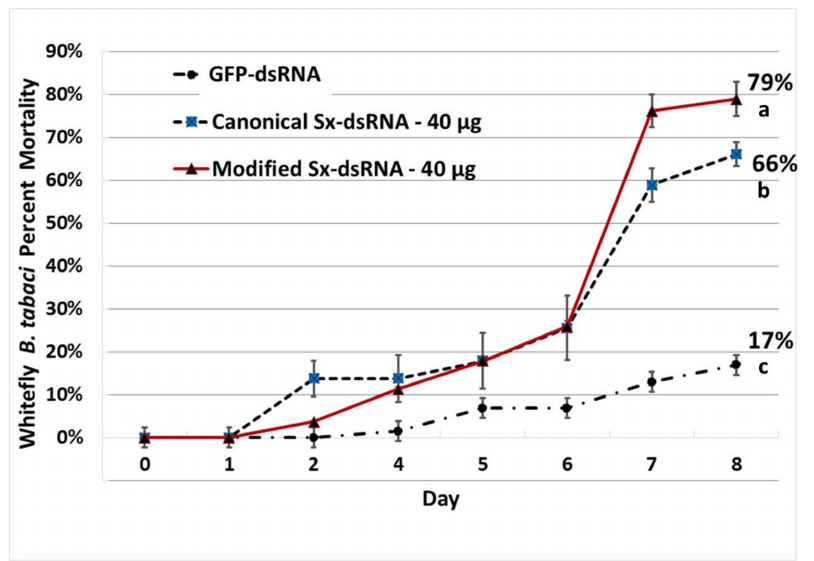
Figure 9. Average Percent Whitefly Mortality. Adult B. tabaci after an 8-d feeding access period on Syntaxin -dsRNA treated okra seedlings. Mortality was significantly greater in the modified Syntaxin- dsRNA treatment (79%) compared to the unmodified Syntaxin -dsRNA 66%) ( p < 0.05), and to the GFP-dsRNA control (17%) ( p < 0.01). One way ANOVA determined statistically significant differences between group means, followed by post-hoc Tukey ( p < 0.01). Error bars represent ± SE of the means (n = 9) of three biological replicates, three technical replicates, from three independent experiments. Lines with different letters are significantly